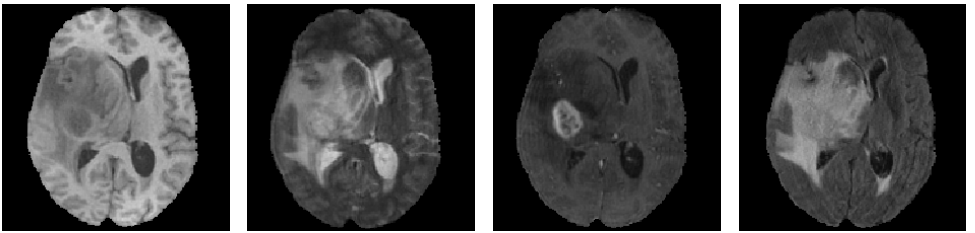
Figure 5. T1, T2, T1CE and FLAIR MR